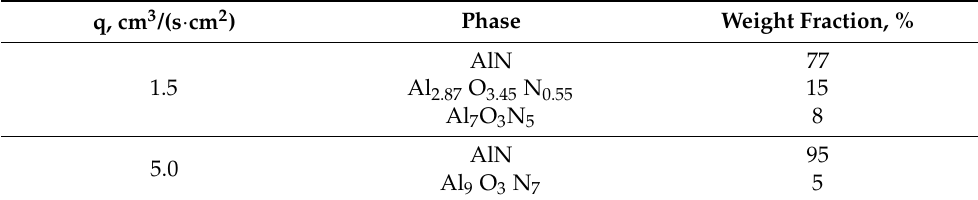
3.5.2. Phase Composition of the Combustion Products Obtained in the Nitrogen–Argon Flow XRD patterns of the combustion products obtained from the (70% AlN + 30% Al) sample in the nitrogen–argon flow are shown in Figure 10.